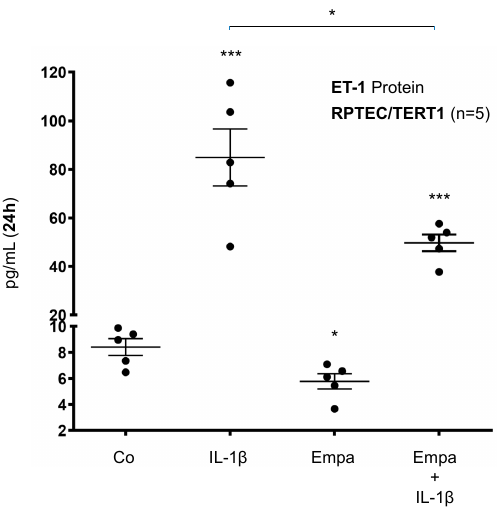
Figure 5. Inhibitory e ff ect of empagliflozin on basal and IL-1 β -induced ET-1 protein expression in human proximal tubular cells. RPTEC / TERT1 cells were serum- and supplement-starved for 24 h and then stimulated for 24 h with IL-1 β (10 ng / mL), 500 nM Empa, or a combination of Empa (500 nM) and IL-1 β (10 ng / mL). Controls (Co) were left unstimulated for 24 h. Cell supernatants from n = 5 independent experiments were used for ELISA. Data are presented as concentrations (pg / mL) when compared with ET-1 control levels. For each experimental condition, data of five independent experiments are presented as dots in scatter plot graphs with the respective mean ± SEM bars. IL-1 β induced ET-1 protein expression 10-fold (*** p < 0.001 compared with unstimulated control cells). Empa downregulated basal ET-1 protein expression by 0.69-fold (* p < 0.05 compared with unstimulated control cells). Administration of Empa in the presence of IL-1 β resulted in a 0.59-fold inhibition of IL-1 β -induced ET-1 protein expression (* p < 0.05 when compared with IL-1 β -stimulated cells).